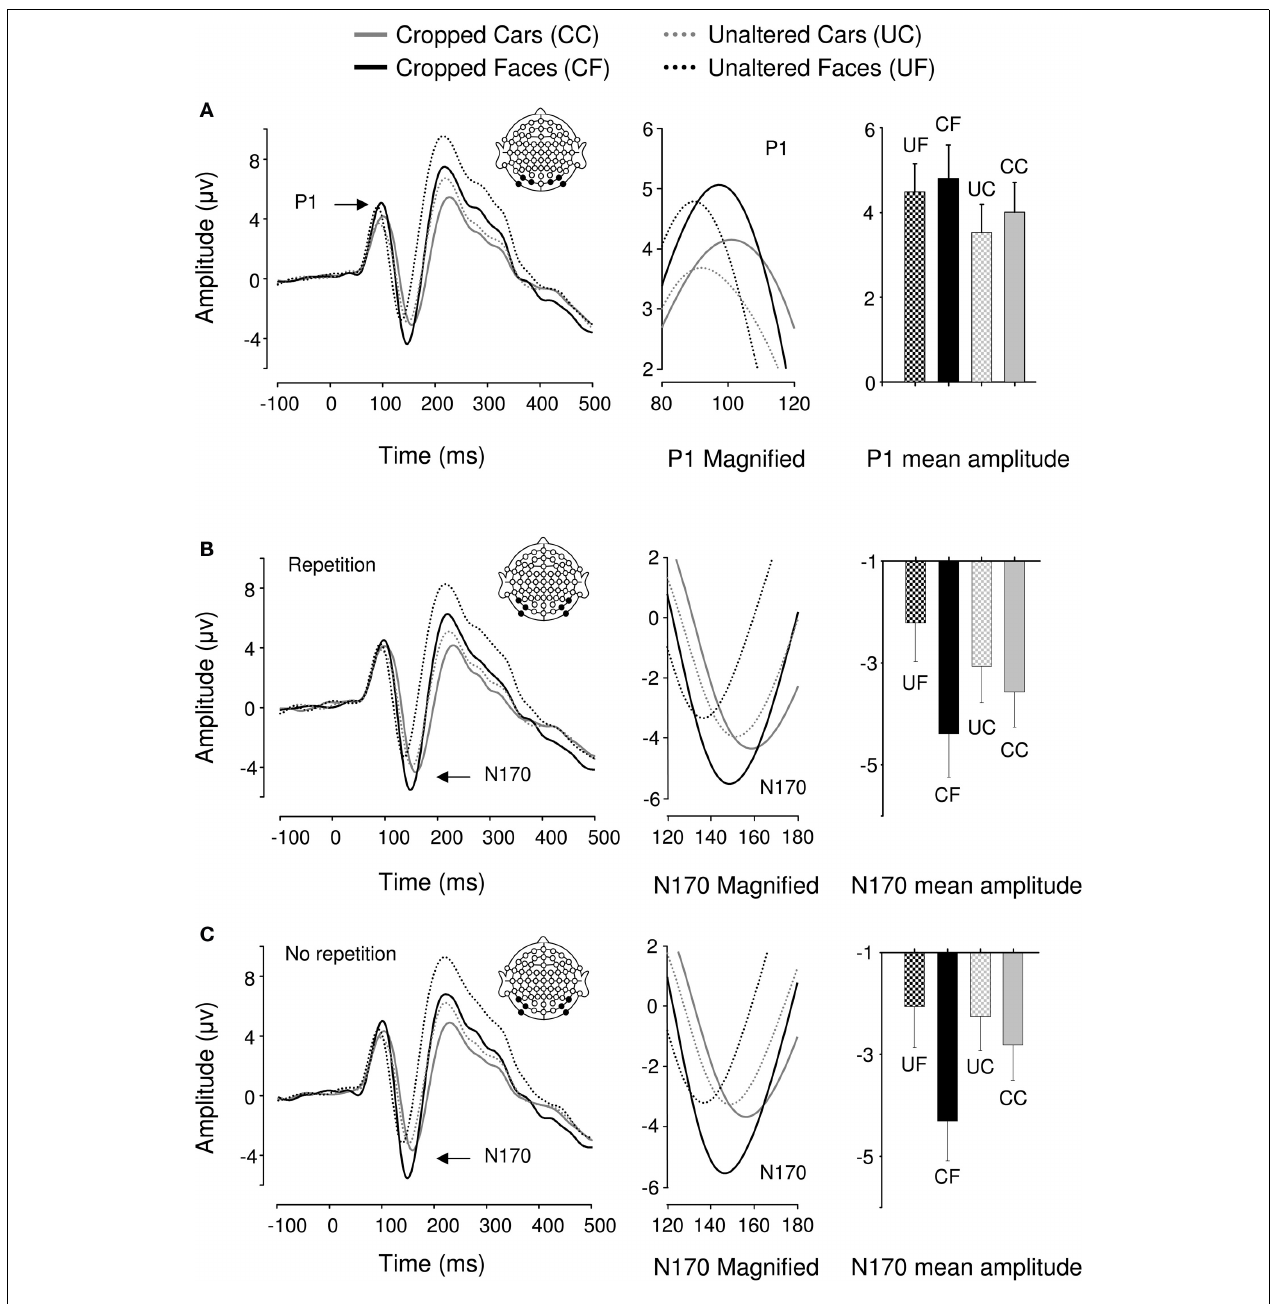
right: linear derivation of electrodes P7, P8, PO7, PO8, PO9, and PO10 in the experimental block featuring stimulus repetitions, magnification of the N170, and N170 mean amplitudes. (C) Linear derivation of electrodes P7, P8, PO7, PO8, PO9, and PO10 in the experimental block without stimulus repetition, magnification of the N170, and N170 mean amplitudes. Error bars depict